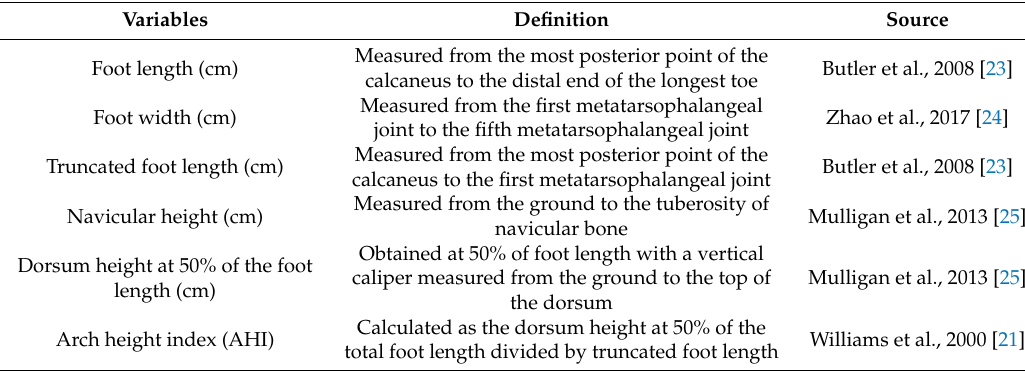
Table 1. Measured foot morphological